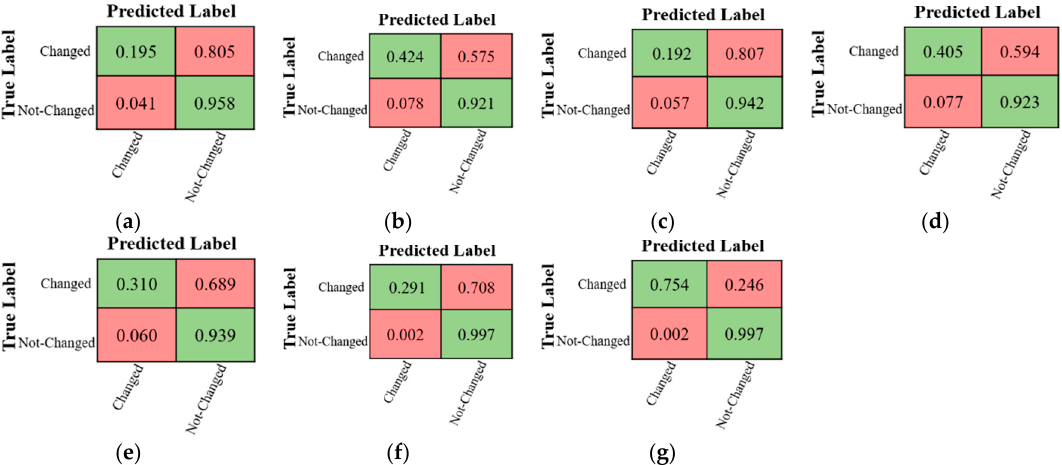
Figure 14. The confusion matrices of different CD methods for the Multispectral-Saclay dataset. ( a ) CVA-SVM, ( b ) MAD-SVM, ( c ) PCA-SVM, ( d ) IR-MAD -SVM, ( e ) SFA-SVM, ( f ) 3D-CNN, and ( g ) Proposed Method.